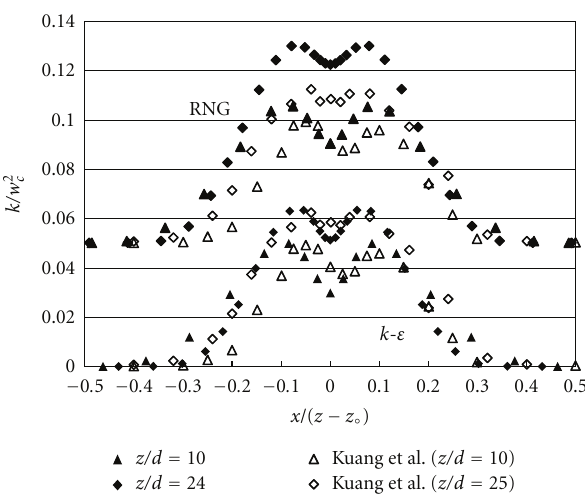
Figure 11: Profiles of turbulent kinetic energy in ZFE.